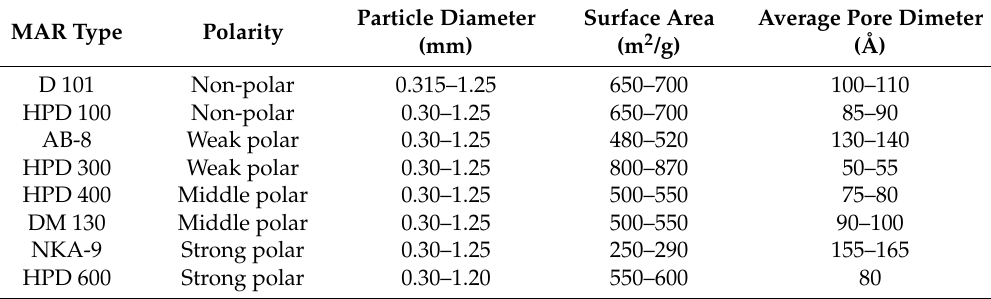
Table 1. Physical properties of macroporous resins used.